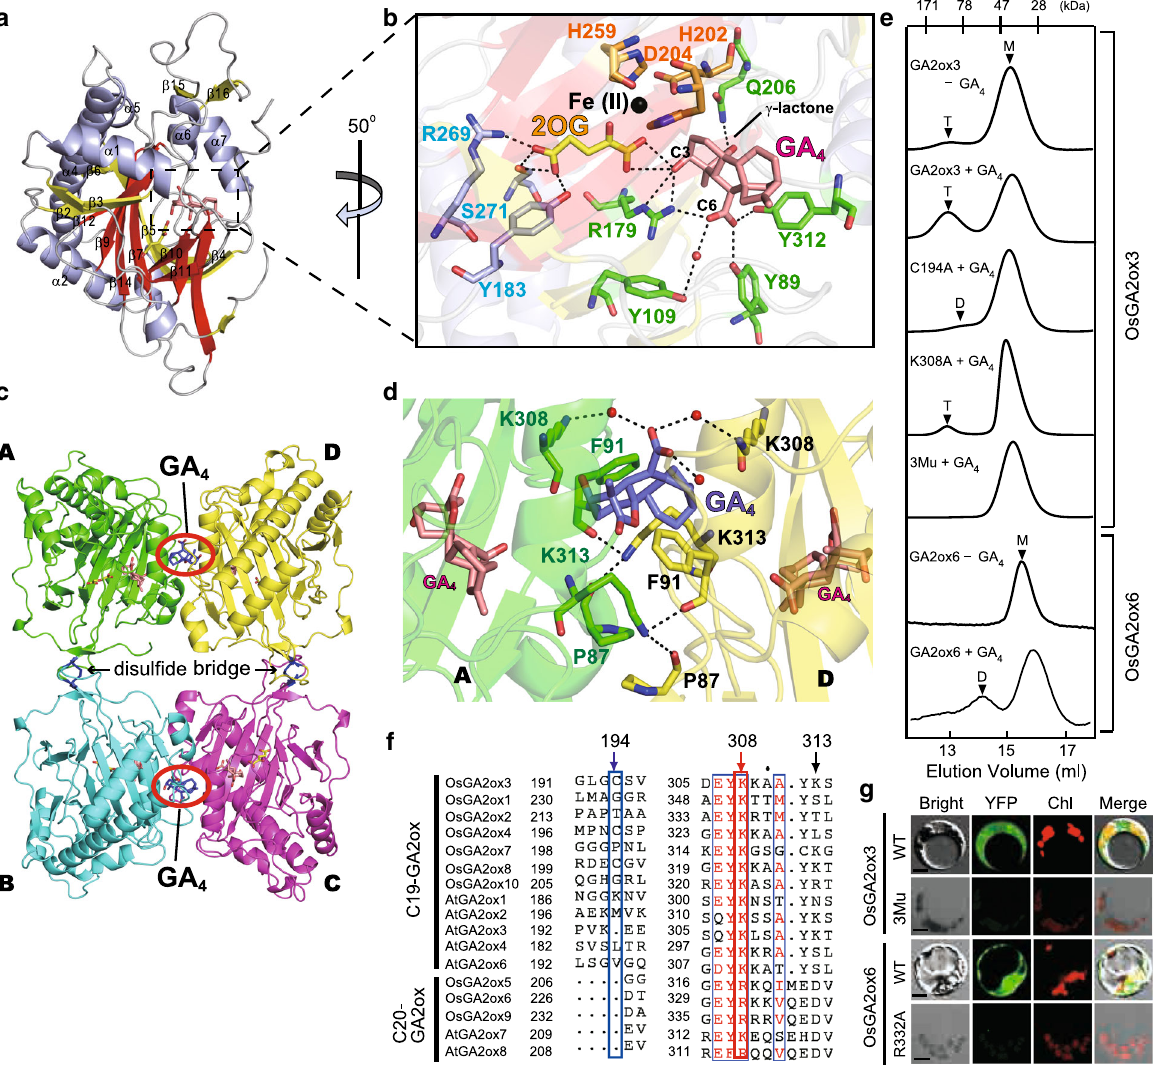
Fig. 1 OsGA2ox3 forms GA-mediated tetramer structure. a Crystal structure of OsGA2ox3. The α -helices are shown in blue, the common core fold is shown in red and none core β -strands are in yellow. b Close-up view of the active site. Important active site residues 2OG and GA 4 are shown in yellow and pink with stick form, respectively. Fe(II) is colored in black. The amino acids interacting with 2OG (R269, S271, and Y183 shown in blue characters), with Fe (II) (H202, D204, and H259 shown in orange characters) and with GA 4 (Q206, Y312, Y89, Y109, and R179 shown in green characters). c Overall structure of OsGA2ox3 tetramer composed of four subunits A – D (see details in the text). d Close-up view of the interface containing GA 4 between subunit A and D. The GA 4 in the interface and active site of subunit A and D are shown in blue and pink, respectively. Amino acids involved in interaction with the interface GA 4 are highlighted, whereas the hydrogen bonds mediated by two water molecules (red spheres) are also indicated by dashed lines. e The gel fi ltration pro fi le of WT-OsGA2ox3, WT-OsGA2ox6, and their mutation derivatives with or without GA 4 . 3Mu is OsGA2ox3 carrying C194A, K308A, and K313A. T, D, and M indicate the expected elution positions for tetramers, dimers, and monomers of OsGA2oxs. f Alignment of amino acids involved in multimerization of GA2oxs from rice and Arabidopsis, 194th, 308th, and 313th. The residue at the position of 308 is always shared by K or R. g BiFC analysis of multimer formation of WT-OsGA2ox3, WT-OsGA2ox6, and their mutation derivatives. YFP yellow fl uorescent protein, Chl auto fl uorescence of chloroplasts. Scale bar = 10 μ